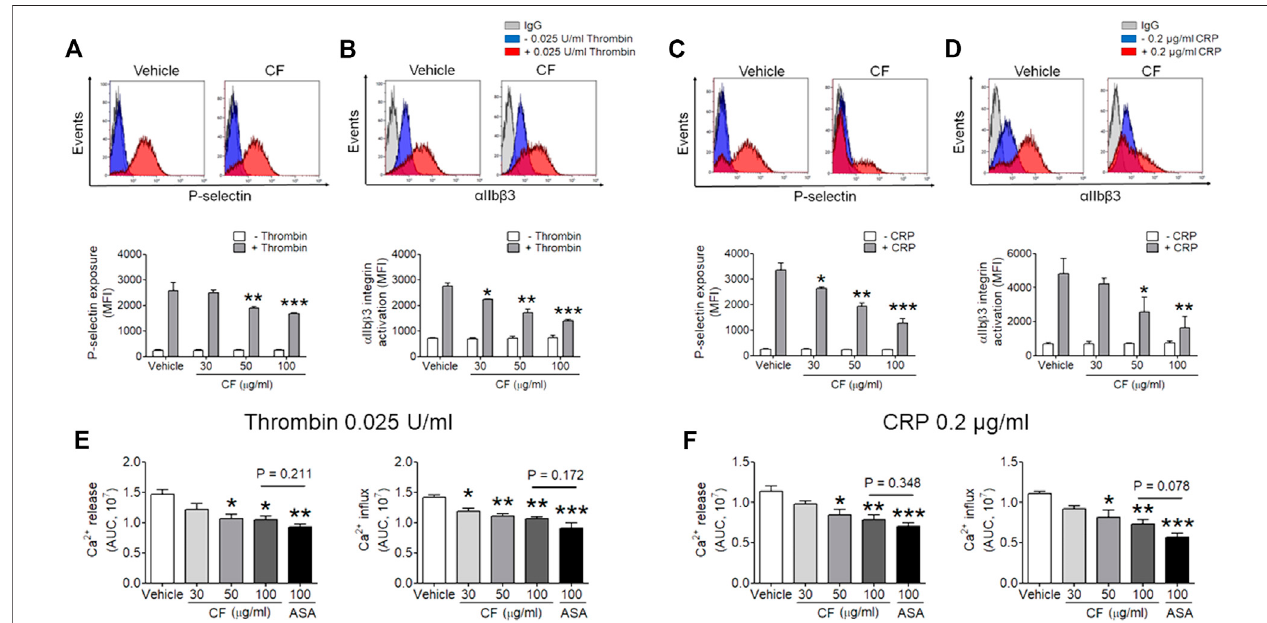
FIGURE 2 | Inhibitory effect of C. fragile on P-selectin exposure, α IIb β 3 integrin activation, and Ca 2+ mobilization during platelet activation. Mouse platelets were pre-treatedwiththeconcentrationof C.fragile (30,50,and100 μ g/ml),andstimulatedwith0.025 U/mlthrombin (A,B) or0.2 μ g/mlCRP (C,D) .P-selectinexposureand α IIb β 3 integrin activation were analyzed by fl ow cytometry as described in Methods. The binding of anti-activated α IIb β 3 (JON/A) and anti-P-selectin antibodies to plateletswas calculated bytheratio ofthegeometric mean fl uorescence intensity(MFI) value ofantibodies tothatofcontrolIgG. Datarepresent mean ± SD ( n (cid:2) 5). *: p < 0.05, **: p < 0.01, and ***: p < 0.001 vs vehicle control after ANOVA and Dunnett ’ s test. In Ca 2+ mobilization assay, mouse platelets were resuspended in HEPES- Tyrode buffer without 1 mM